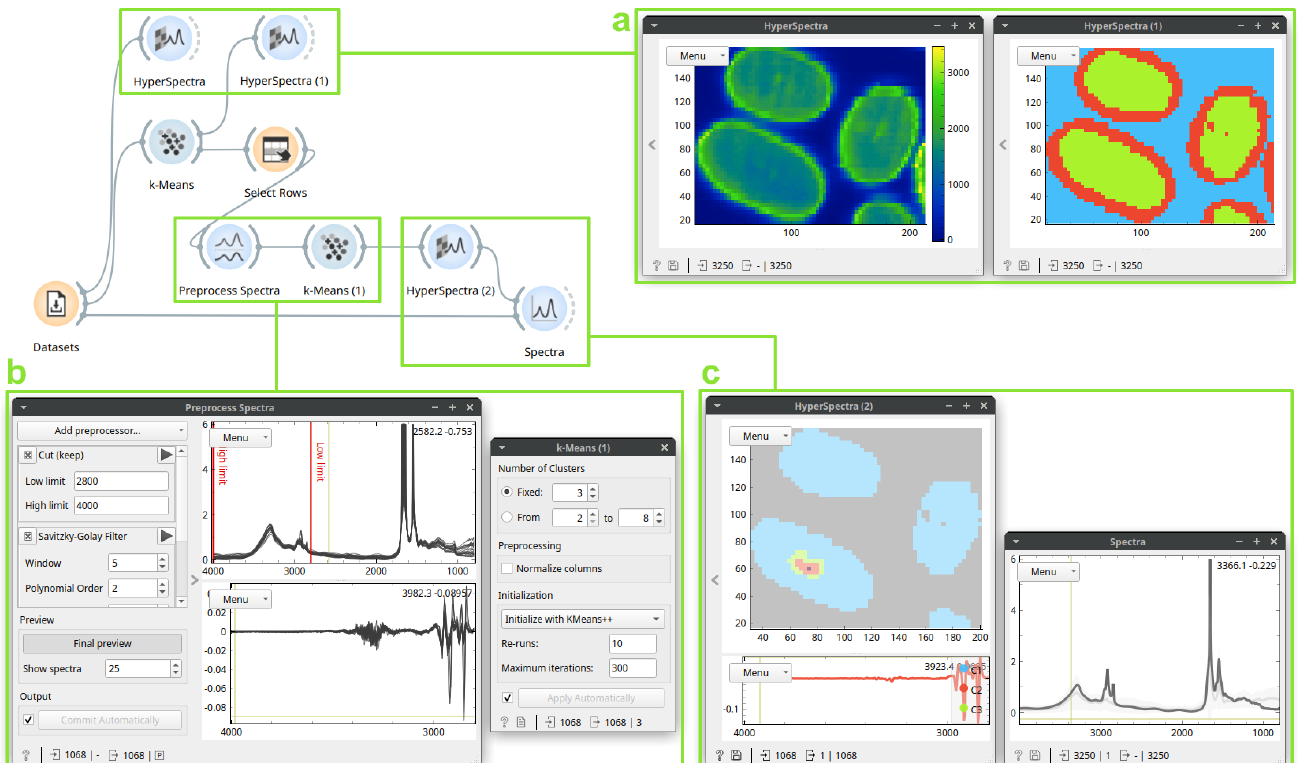
Figure 2. An unsupervised analysis on a dataset of multiple hair sections. The HyperSpectra (box a , left ) displays integrals of the spectral content. The first k-Means clustering outputs three groups of spectra based on their spectral similarity. As these groups correspond to sample morphology well ( HyperSpectra , box a , right ), selecting ( Select Rows ) only the innermost removes both the background and the edges (where scattering occurs). After preprocessing (a wavenumber region selection and second derivatives; Preprocess Spectra , box b ), k-Means clustering discovers a cluster at the center of the largest cross-section ( HyperSpectra , box c , left ). A selected spectrum from the cluster in non-derivative space, shown in the Spectra widget (box c , right ), contains a lipid signature characterized by peaks between 3000–2800 cm − 1